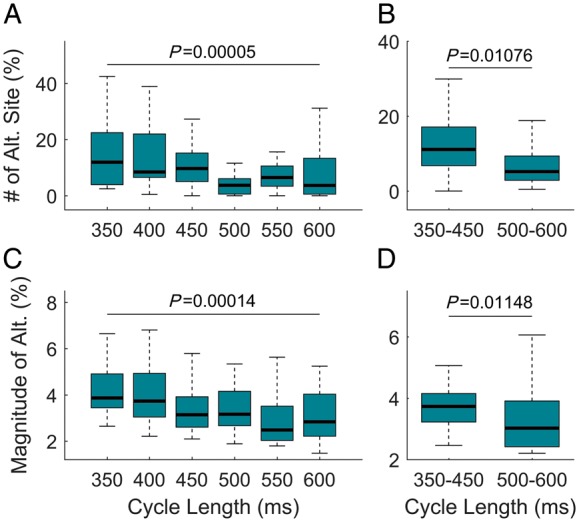
Spatio-temporal distribution of APD alternans. Alternans and cycle length. (A) Number of sites showing alternans relative to the total number of sites at a given CL. (B) Mean number of alternans-susceptible sites for CL ≤450 ms and CL ≥500 ms. (C) Magnitude of alternans relative to the mean ARI at a given CL. (D) Mean magnitude of alternans relative to mean ARI for CL ≤450 ms and CL ≥500 ms. P-values for group (Kruskal–Wallis test) and pairwise (Wilcoxon signed-rank test) are reported (n = 30). APD, action potential duration; ARI, activation-recovery interval; CL, cycle length.